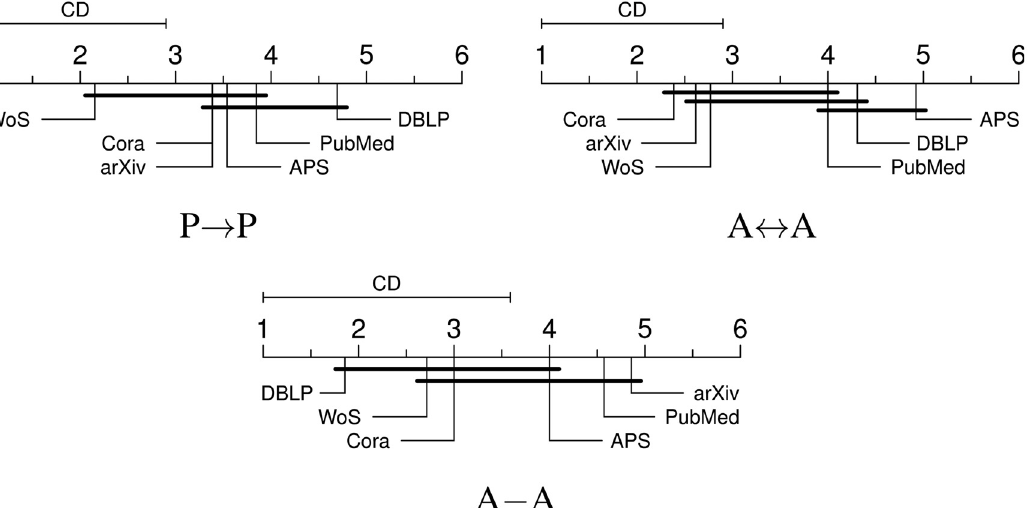
Fig 4. Final overall ranking. Ranking of databases for all three network categories. Critical difference (CD) indicates what range of ranking differences is not statistically significant. The difference in ranking of databases underlined by the common bold line are not statistically significant